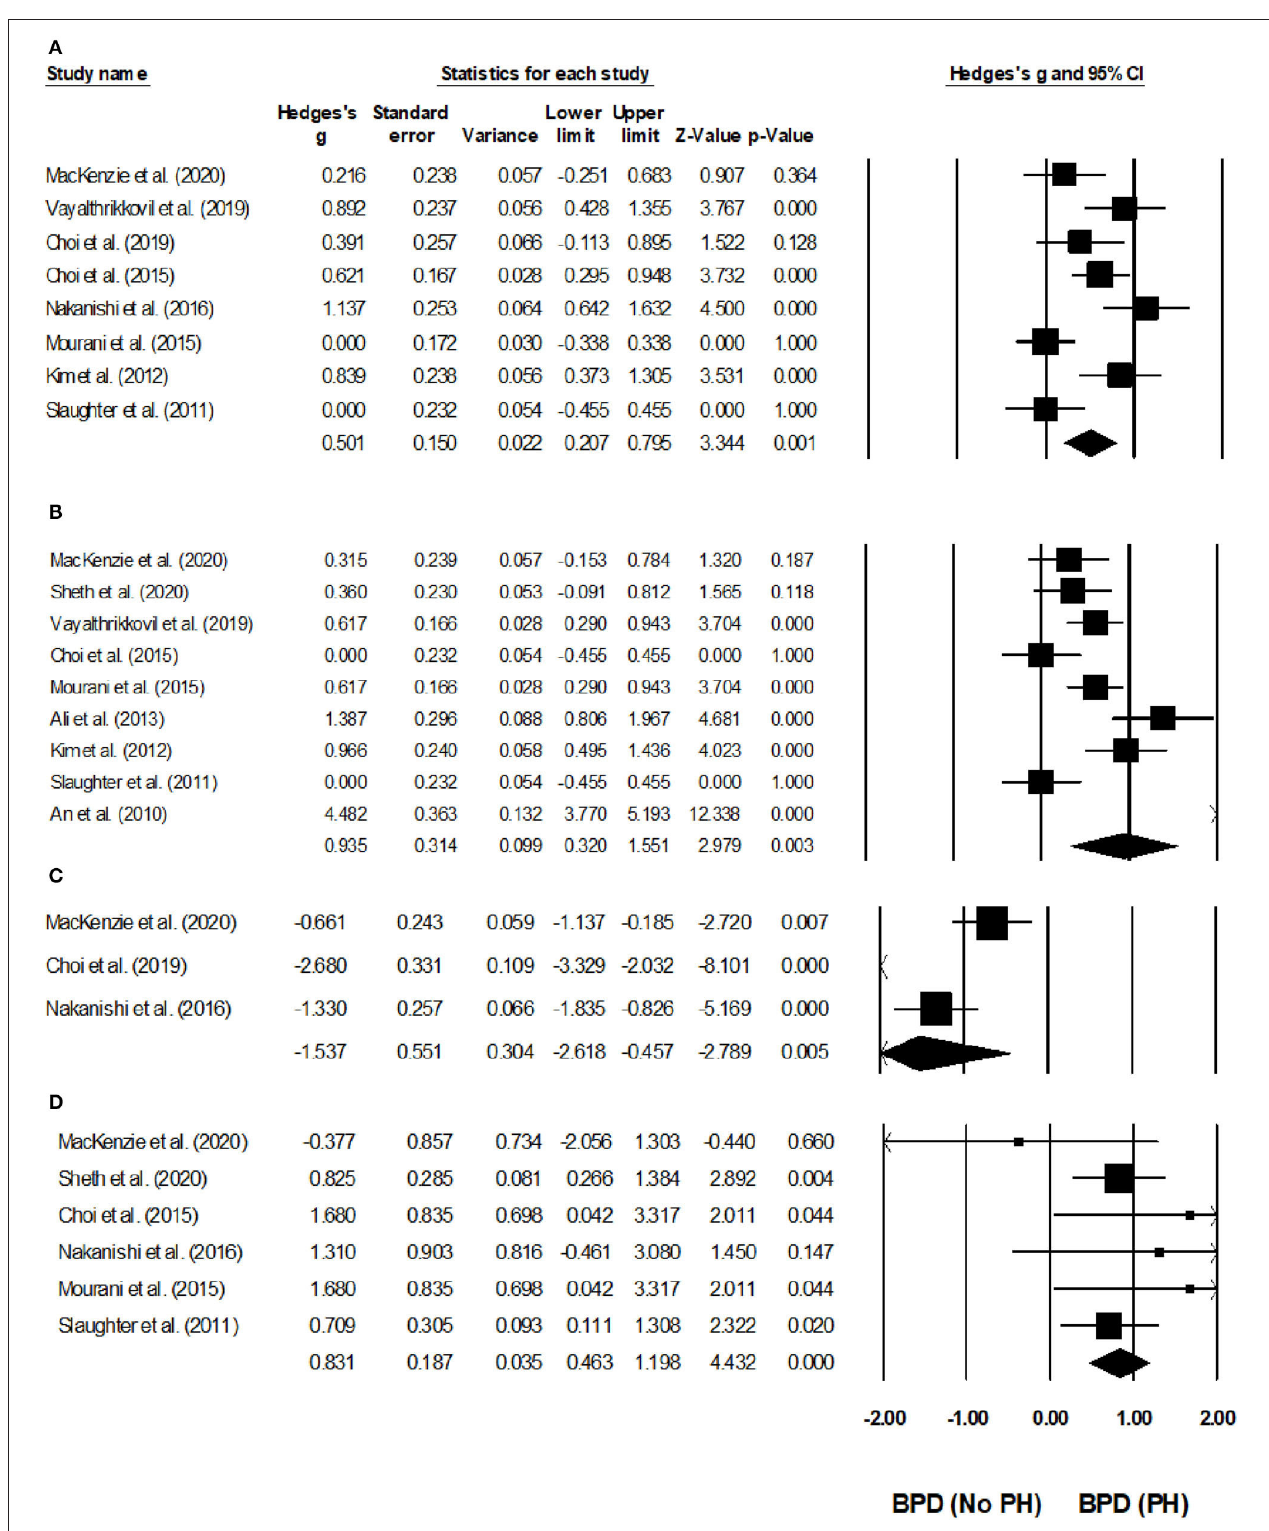
FIGURE 5 | Forest plots for studies evaluating outcomes in infants with BPD infants with/without pulmonary hypertension. (A) Duration of hospital stay, (B) duration of oxygen received, (C) cognition score, (D) mortality. Weighted effect sizes are presented as black boxes, whereas 95% confidence intervals are presented as whiskers. A negative effect size represents a favorable outcome for infants with BPD without pulmonary hypertension, a positive effect size represents a favorable outcome for infants with BPD and pulmonary hypertension.